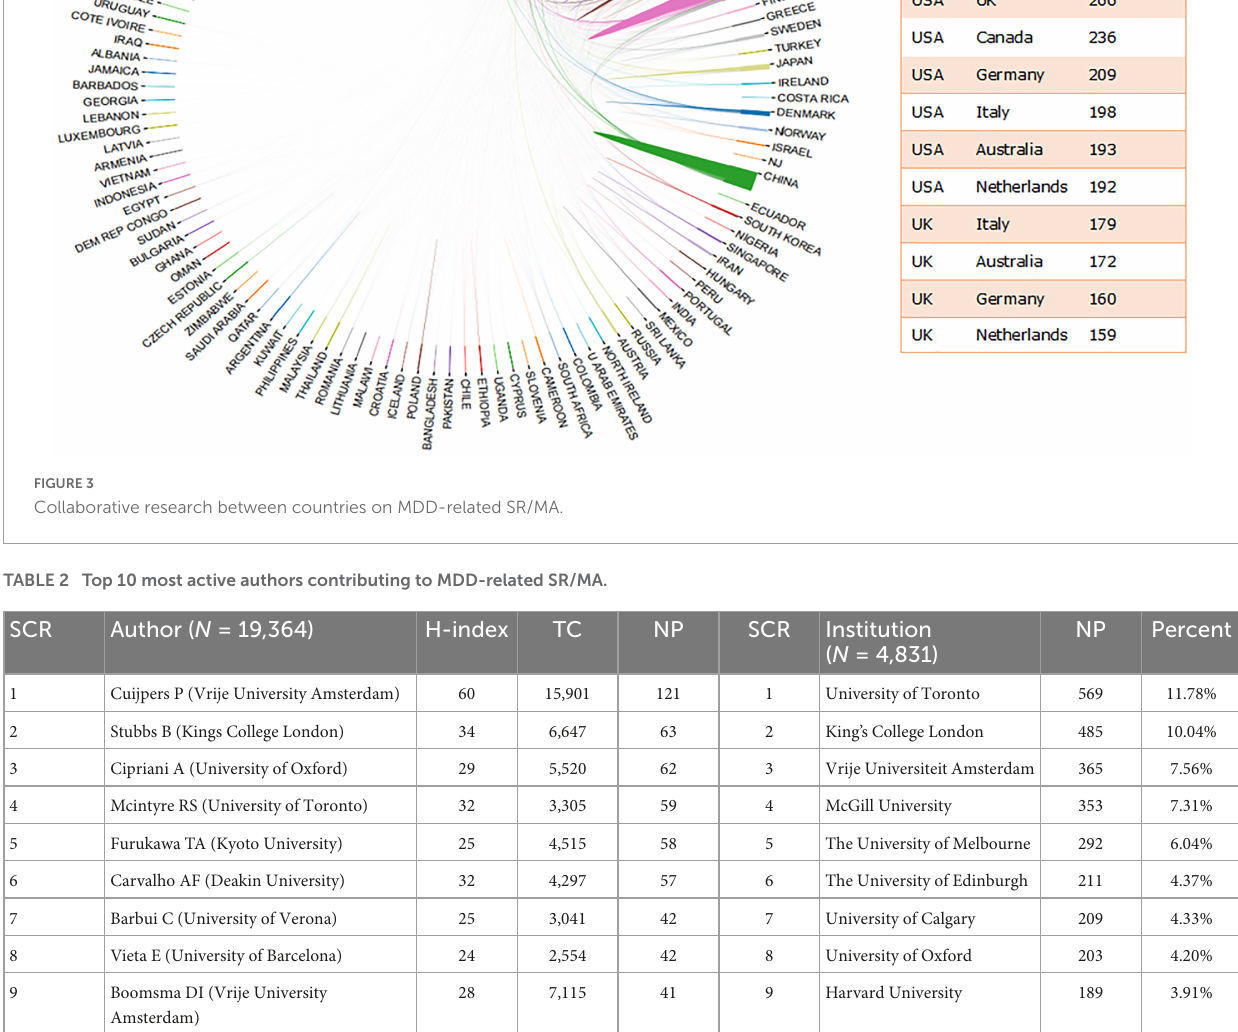
the brain stimulation treatments of MDD (yellow color) such as “transcranial magnetic stimulation,” “prefrontal cortex,” and “electroconvulsive-therapy.” Figure 4B shows the time change of these keywords. Keywords colored in yellow indicate that they have been used in recent years such as “bipolar disorder” (APY: 2016.89) and “genome-wide association” (APY: 2016.79). Keywords related to drugs or